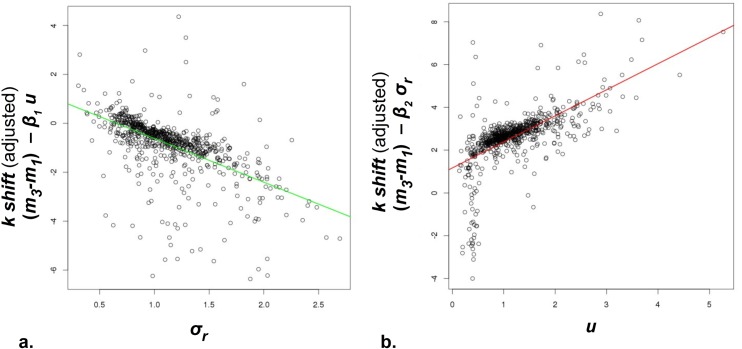
The apparent discounting shift ma-mb, considered in the direction of the ‘other’, was regressed against σr and u in the whole sample, N = 738.This shift is plotted against each variable removing the variance predicted by the other. We focused on variable inter-relationships, thus ignoring y-intercept terms. a. Shift vs. reference dispersion σr. The bigger the likely distance (σr) the smaller the shift. b. Shift vs. preference uncertainty u is also in the direction predicted by Bayesian reasoning. We note that in each case the population consists of a denser core of points but also of penumbrae that slightly dilute the overall fits (coloured lines). Here we follow this more conservative whole-sample regression; see S1 Text for post-hoc quality-controlled analyses.